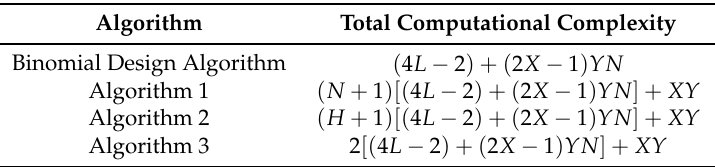
Table 1. Comparison of the computational